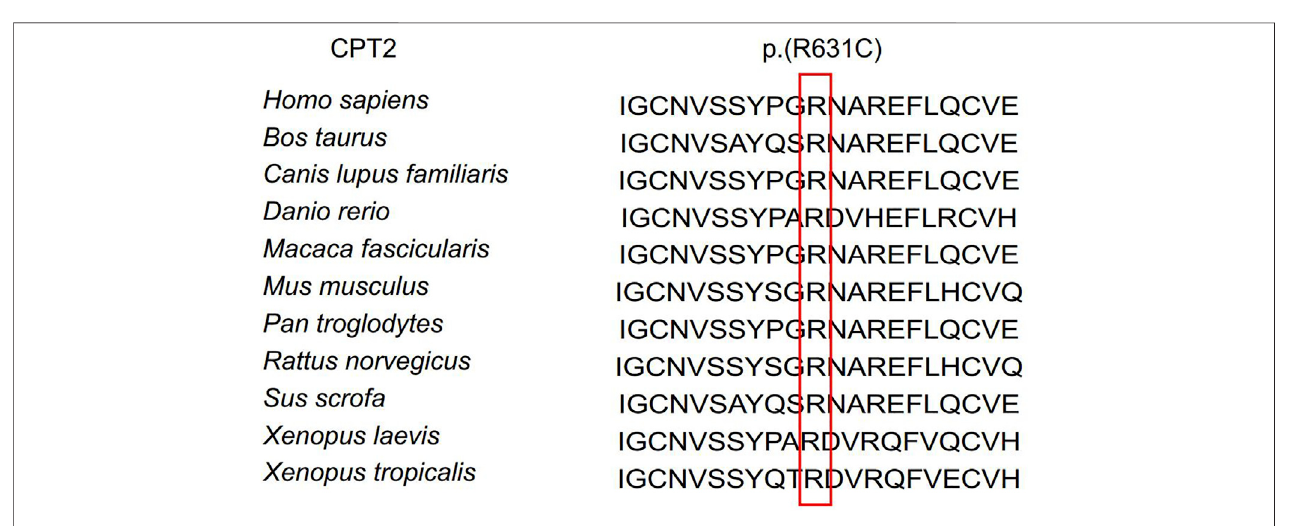
Frontiers in Cell and Developmental Biology |